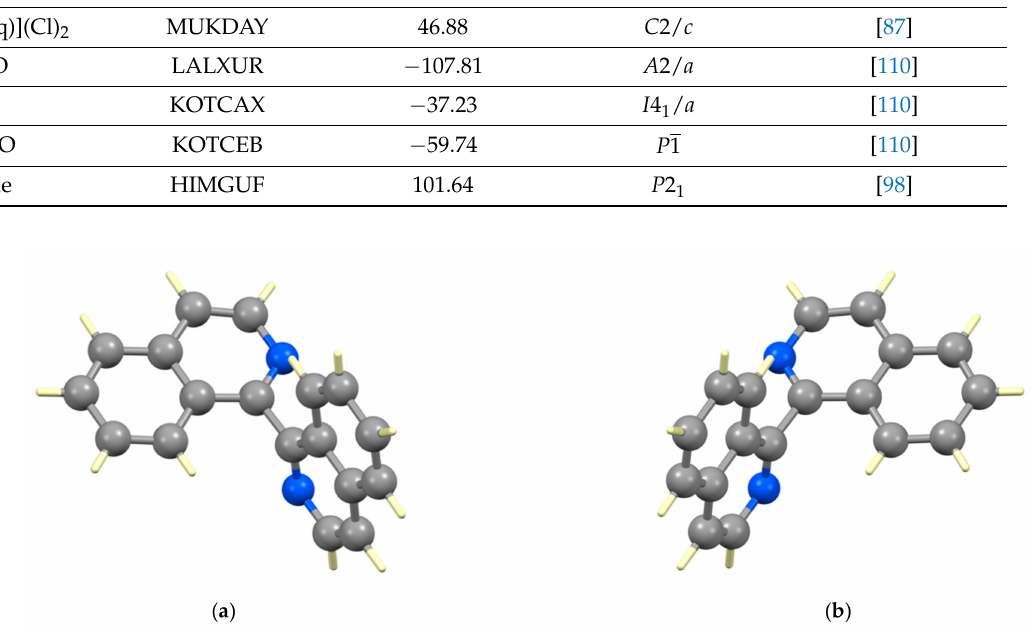
Figure 8. Both enantiomers of 1,1 (cid:48) -biisoquinoline are observed in the crystal structure of rac -biiq; ( a ) (1 M )-biiq and ( b ) (1 P )-biiq